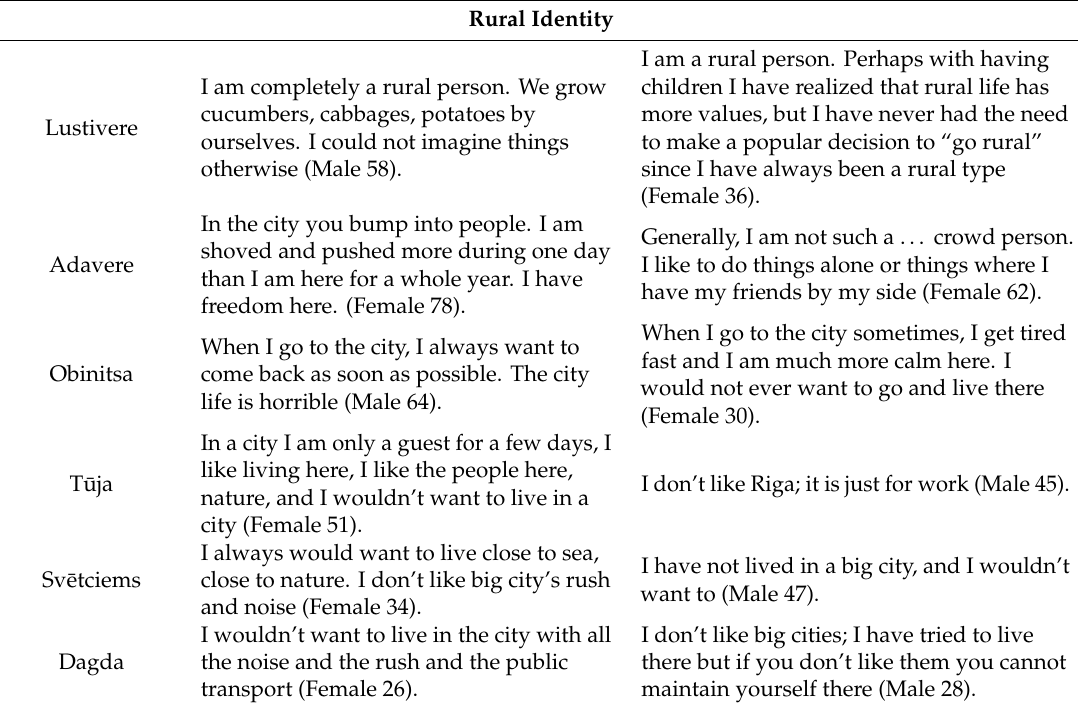
Table 3. Sense of rural